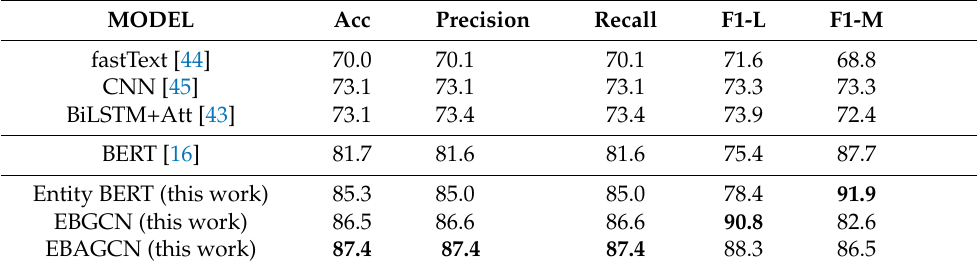
Table 2. Result on self-constructed Chinese dataset